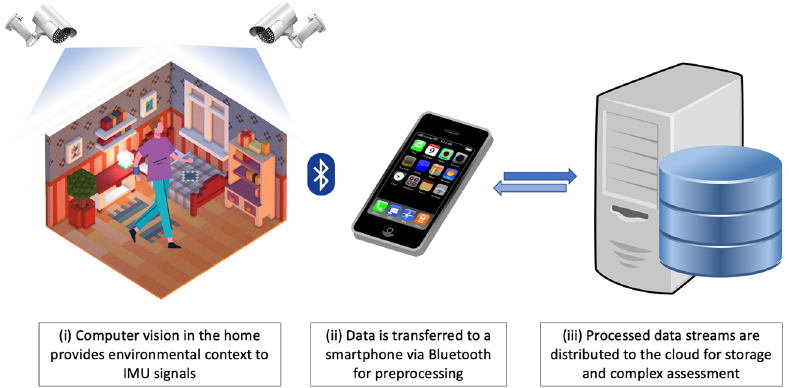
Figure 3. A proposed infrastructure for multi-modal gait assessment in habitual environments. Here, (i) is informed by a computer vision-based system to provide environmental context; a low- cost wearable IMU streams inertial data to a (ii) smartphone, where preprocessing takes place before transmission to (iii) the cloud for storage and further